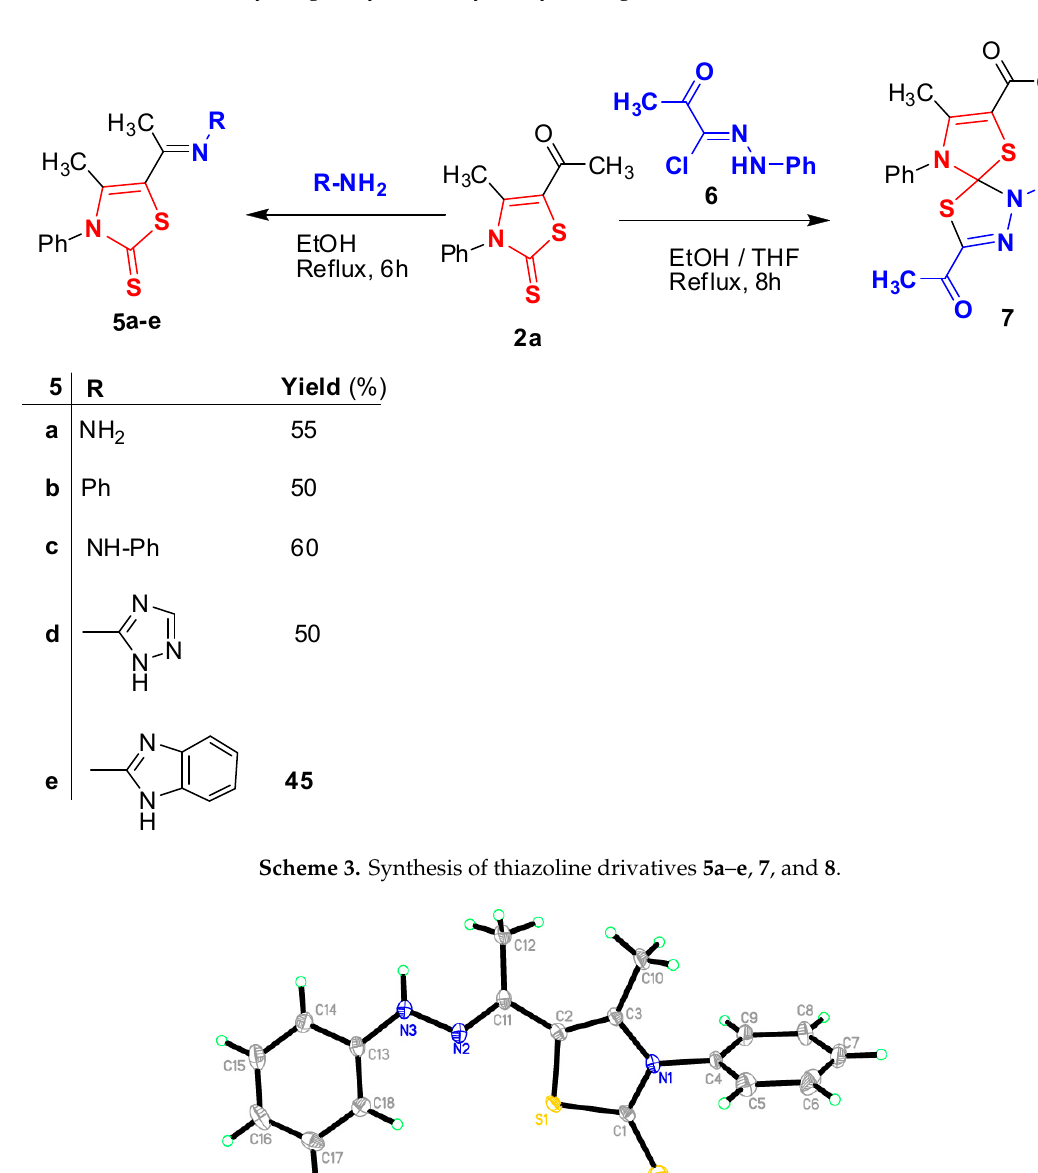
Figure 2. Molecular packing of thiazoline 5c viewed hydrogen bonds, which are drawn as dashed lines along a axis. Table 1. The crystal and experimental data of thiazoline 5c . Crystal Data Chemical formula